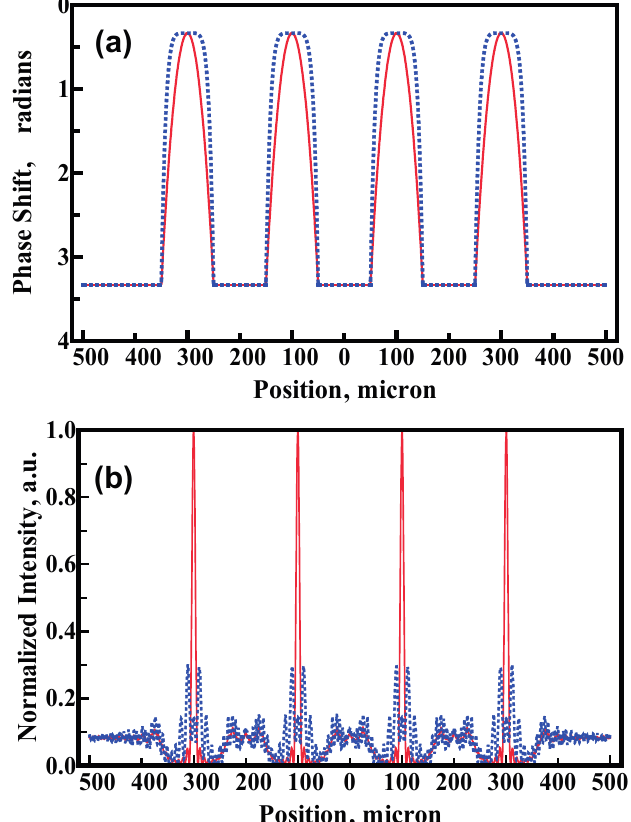
Figure 3. ( a ) The simulated spatial phase shifts of the LC microlens arrays. Blue dotted line stands for periodically trapezoid-like phase shift and red line stands for periodically parabolic phase shift; ( b ) the corresponding intensity distribution at the focal plane for the periodically trapezoid-like phase shift (dotted blue line) and the periodically parabolic phase shift (red